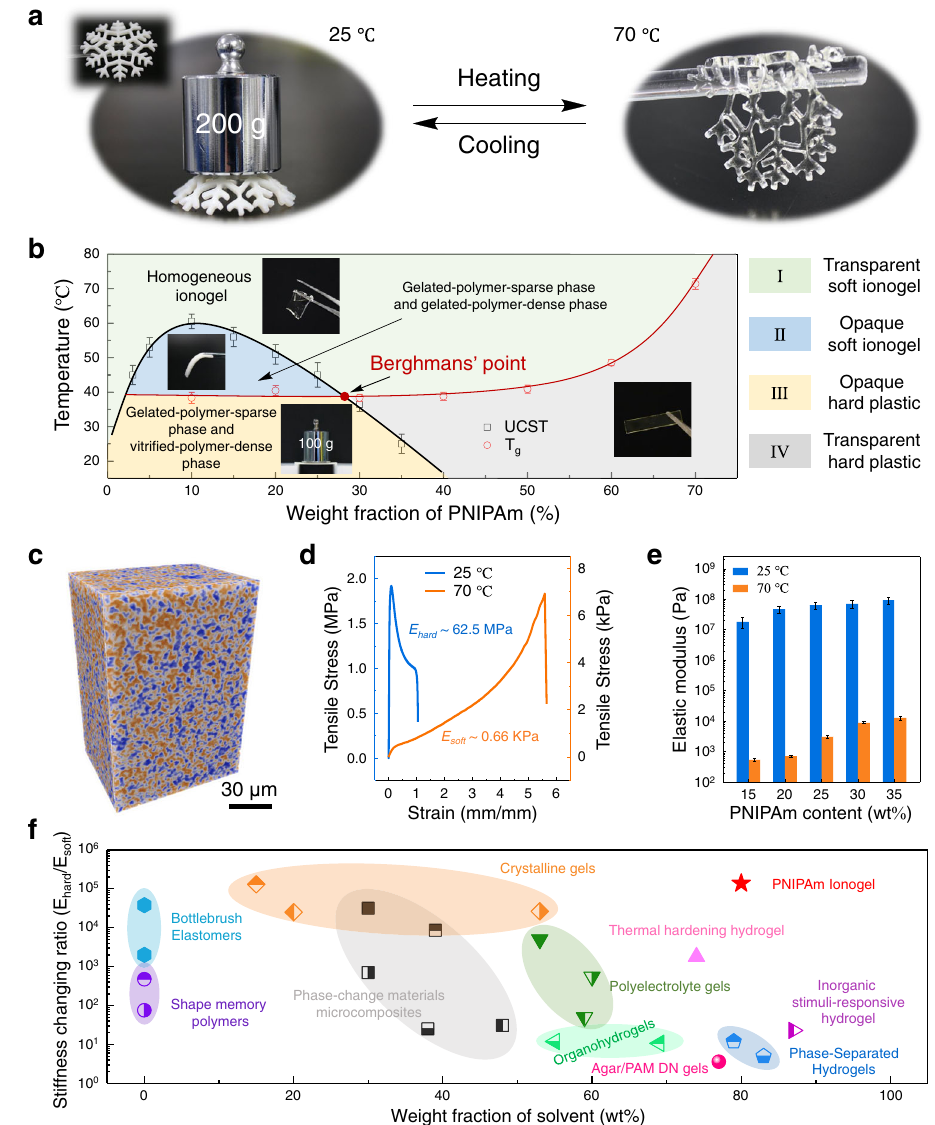
Fig. 2 | Phase diagram and mechanical behaviors of [C 1 MIM][NTf 2 ]-PNIPAm ionogels.a Thephotographsillustratethemechanicalbehaviorofionogel,whichis stiff enough to hold a weight of 200g in the rigid state but soft enough to stick to the glass bar in the soft state. b Phase diagram of PNIPAm ionogel composed of phase separation curve and the T g curve. c Nano CT image qualitatively illustrate the bicontinuous structure of the phase-separated ionogel (the blue phase repre- sentsthe polymer-richregion and the yellow phase represents the